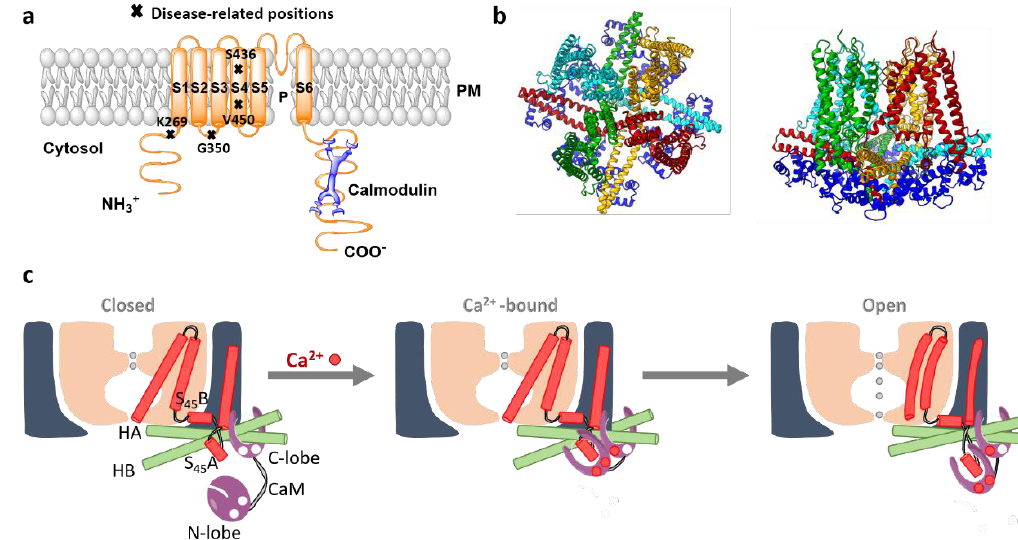
Figure 7. The structure and activation mechanism of SK channels. ( a ) The proposed structure of the SK channel with constitutively bound CaM. P represents the pore region of the channel. Moreover, residues that have been associated with the rare developmental disorder, the Zimmermann–Laband Syndrome, are highlighted. ( b ) The top and side view of SK4 tetramer (PDB ID 6CNM; 4 subunits colored distinct in red, yellow, light blue, green) bound to 4 CaM (dark blue). ( c ) The scheme depicts the stepwise gating mechanism of the SK channel. Under the Ca 2 + free conditions ( left panel ), the SK channel remains closed. The C-lobe of CaM is constitutively associated to the channel, whereas the CaM N-lobe possesses diverse conformations due to a high level of flexibility and almost no present interaction to the channel. The binding pocket of CaM N-lobe at this stage stays closed. In the presence of Ca 2 + , the ions bind to the CaM N-lobe, which structurally rearranges into a more open conformation ( middle panel ). The latter rearrangement allows the interaction of CaM N-lobe with the S 45 A helix. In the following, the N-lobe pulls the S 45 A toward the cytosol, displacing S 45 B away from the pore axis ( right panel ). Subsequently, the S6 helical bundle expands and potentially opens the pore. Modified from [304].